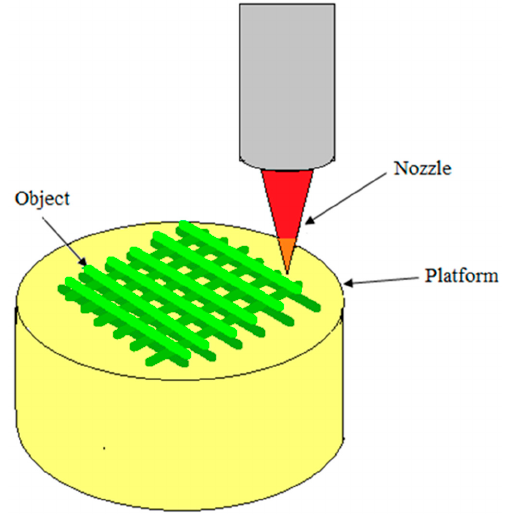
Figure 12. The schematic diagram of 3D printing technique.